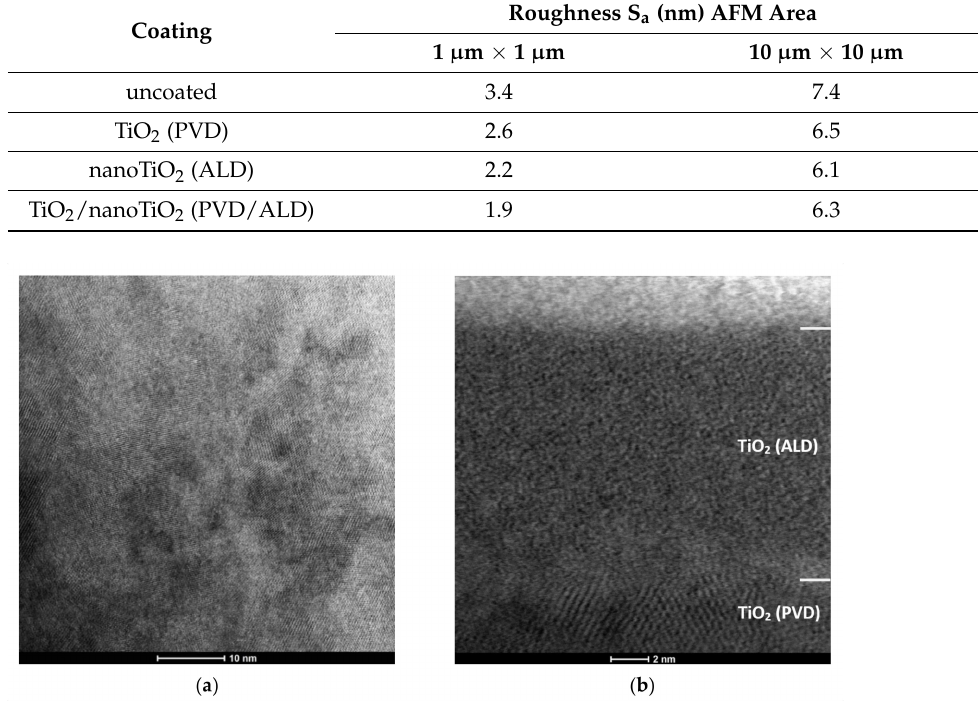
Figure 3. Structure (STEM) of TiO 2 /TiO 2 bimodal coating: ( a ) structure of TiO 2 (PVD) layer and ( b ) structure of TiO 2 (ALD) layer and PVD/ALD transition zone.